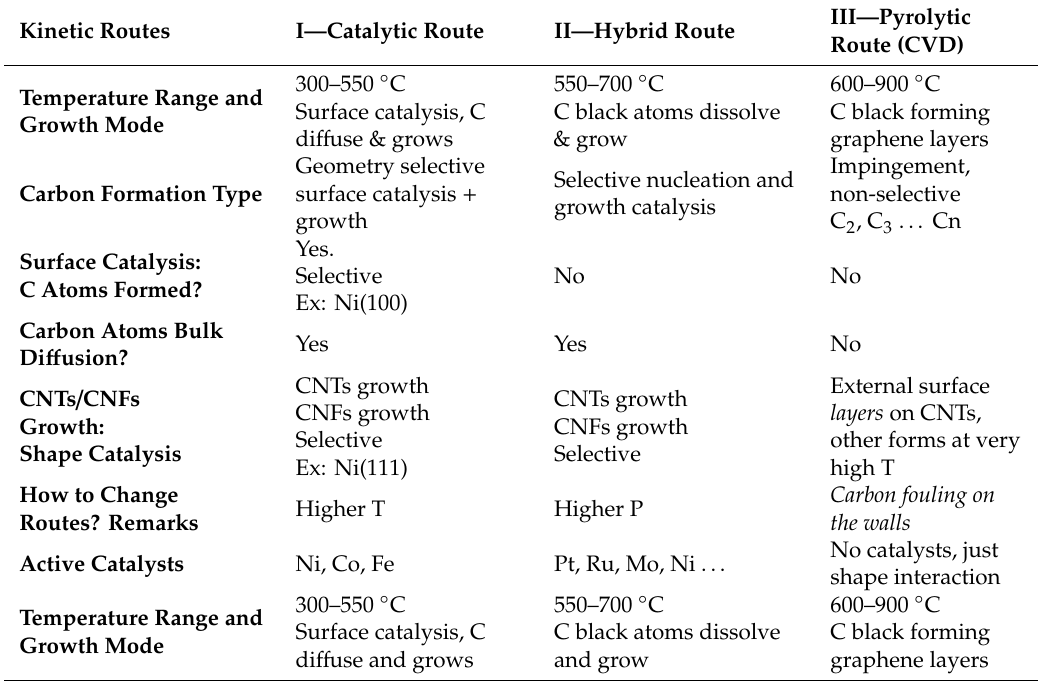
Table 3. Kinetic routes observed in CNT / graphene formation based on several detailed kinetic studies. A remark on how to change routes is